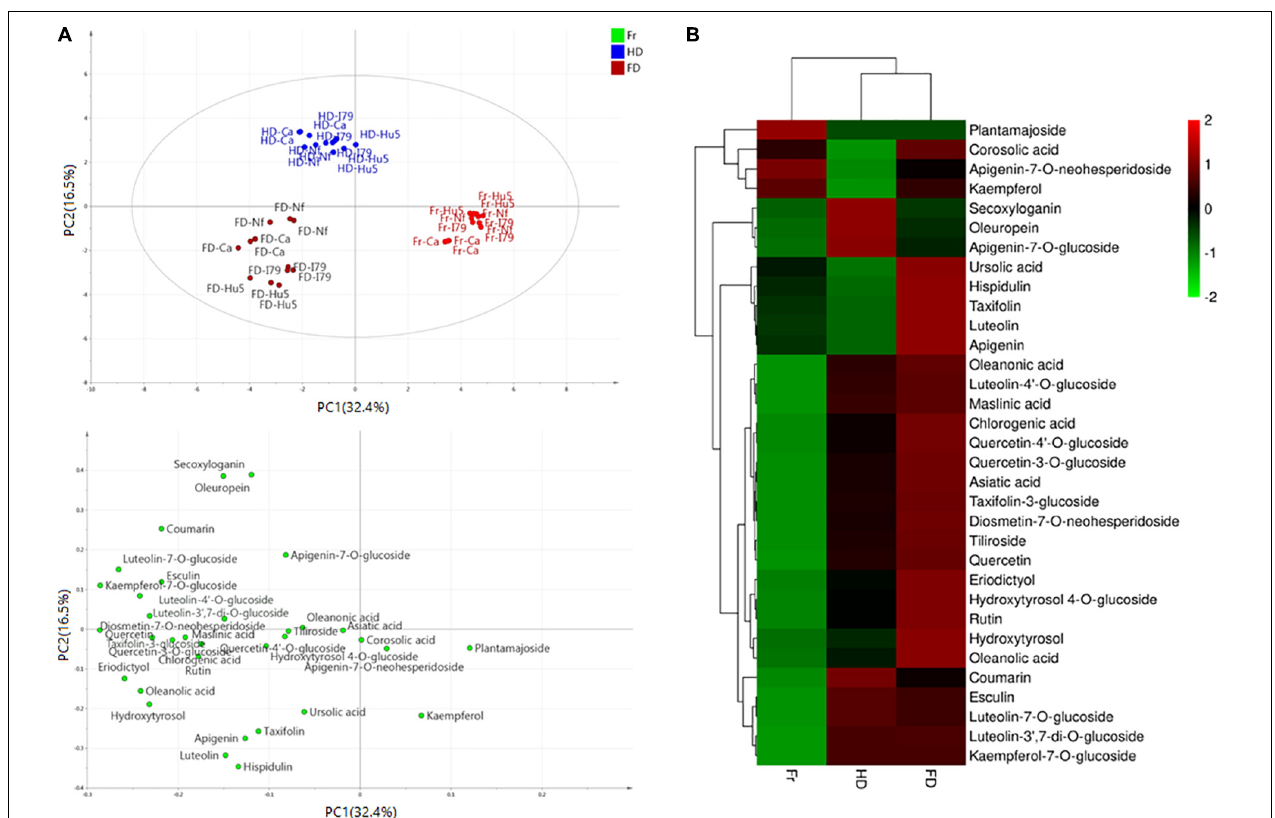
FIGURE 1 | (A) Principal component analysis results of olive leaf samples according to their phytochemical profiles (score plots and loading plot). (B) Clustered heat map analysis of the 33 individual phytochemical compounds in the fresh and dried olive leaf samples. Red color indicates major abundance, green color indicates minor abundance, and Fr, HD, and FD denote fresh, hot air-dried, and freeze-dried olive leaf samples,